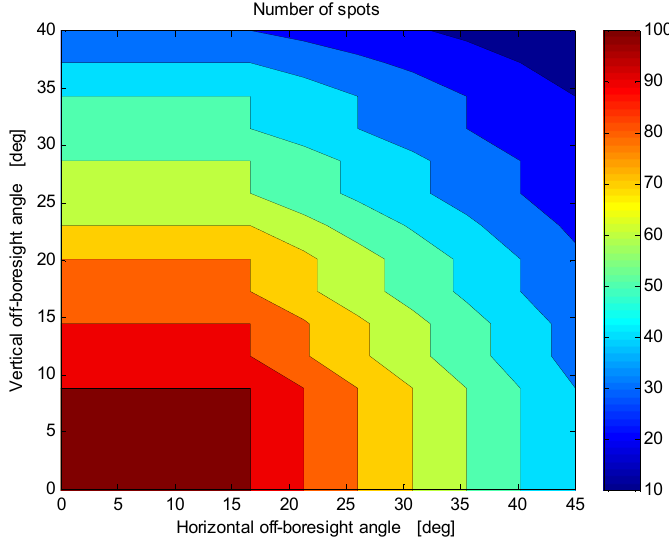
Figure 2. Total number of imaged sun spots versus the sun-line orientation in the sensor FOV: due to symmetry, only data for one FOV quadrant are